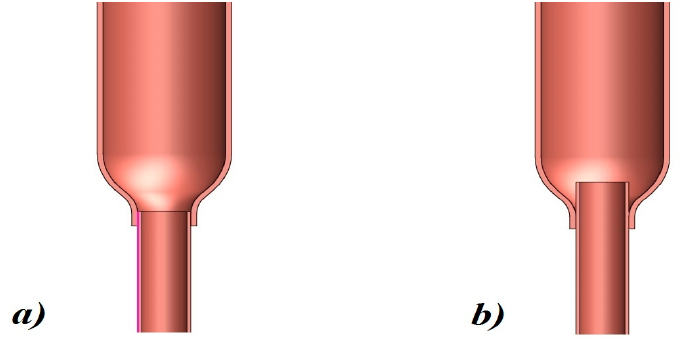
Figure 21. Condenser connection to the adiabatic pipe: ( a )—correct, ( b )—incorrect.